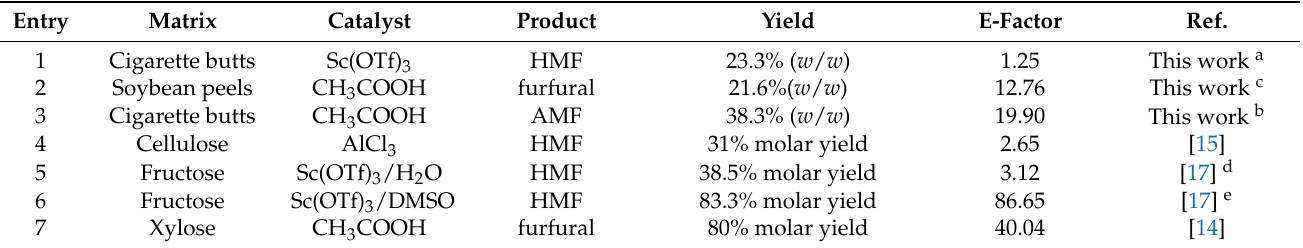
a Table 5, entry 1. b Table 4, entry 2. c Table 4, entry 5, d Reaction in water. e Reaction in